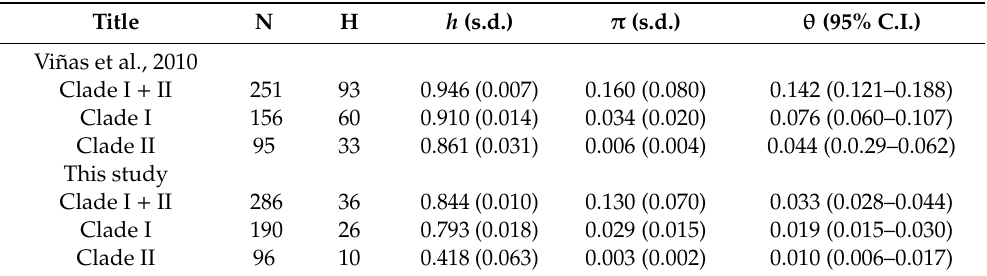
Table 3. Summary of molecular diversity indices for Mediterranean swordfish temporal samples for pooled clades and each clade separately. The number of individuals (N) and haplotypes (H), the haplotype diversity (h), the nucleotide diversity ( π ) and effective population size parameter ( θ ) are shown.